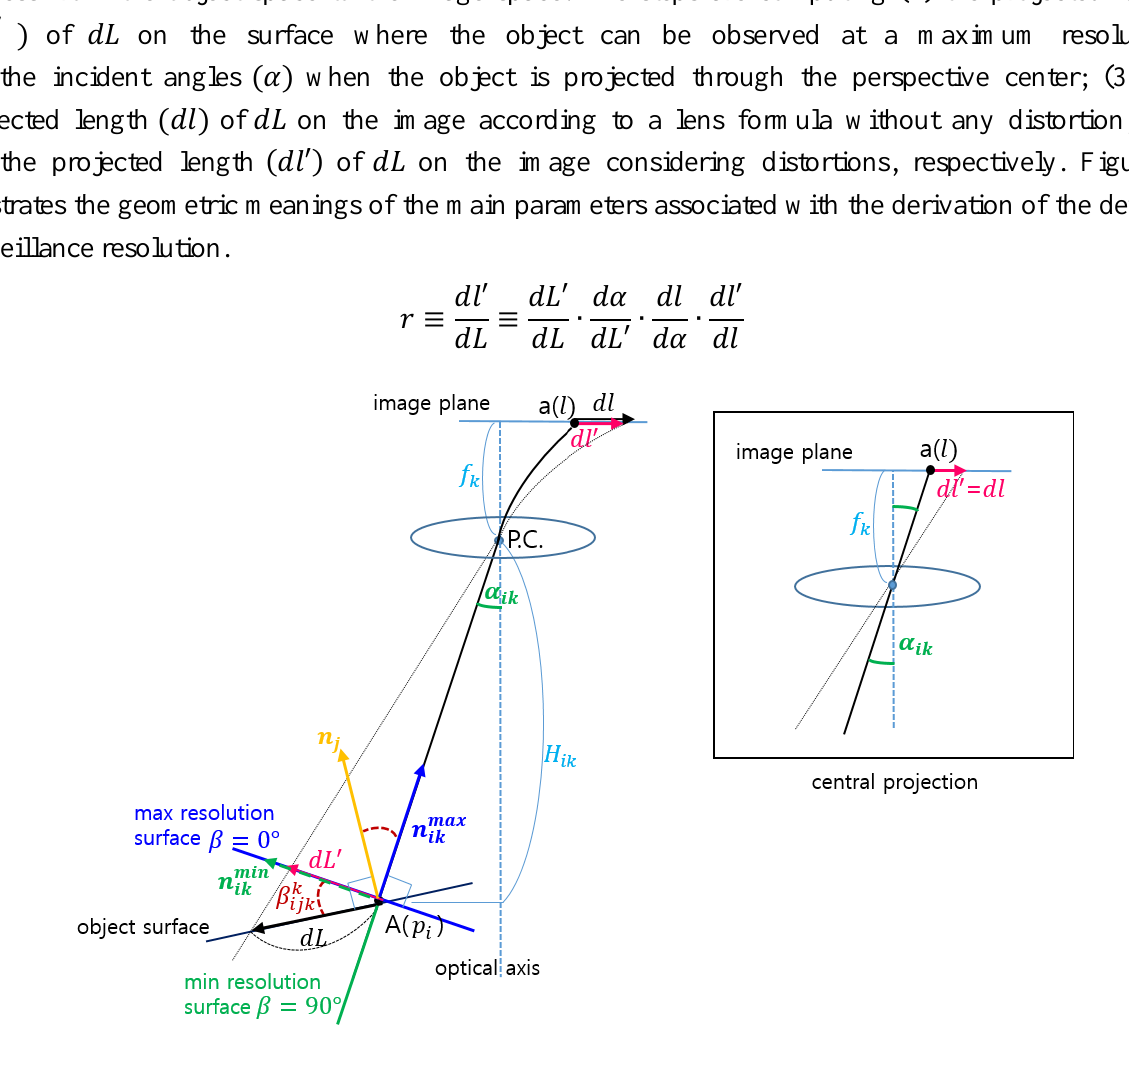
Figure 2. Definition of surveillance